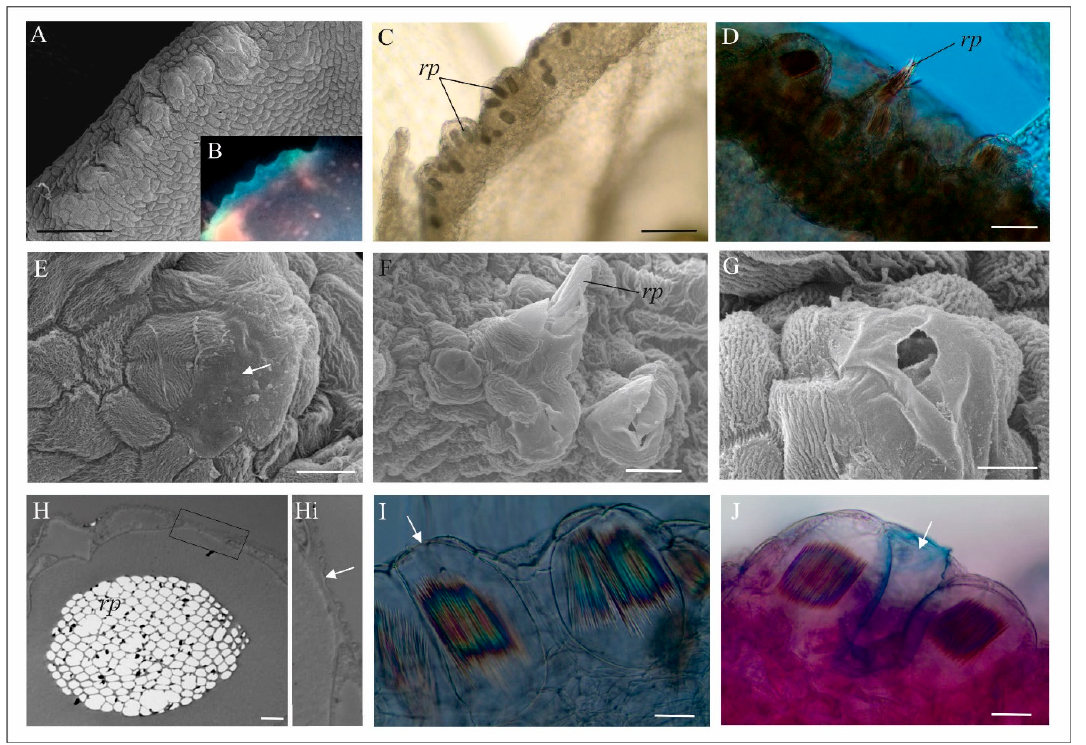
Figure 6. The cells with raphides in the M. monophyllos labellum . ( A ) The bulged structures on the labellum margin (SEM); ( B ) Luminescence of the labellum margin in the UV light (330–380 wavelengths) (LM); ( C ) idioblast with the raphides (fixed cells without staining) (LM); ( D ) raphides after ejection from the idioblasts (LM, DIC); ( E – G ) The bulged structures on the labellum margin-details (SEM); cells with striped cuticle and a single cells with smooth cuticle (arrow ) ; visible ejected raphides ( F ) and perforation ( G ) in the thin, smooth cuticle; ( H ) bundle of the raphides in the idioblast; ( Hi ) inset—fragment of the idioblast cell wall borders with the external environment (TEM); ( I , J ) Idioblasts with the raphides in the subepidermal cells; the fragment of the cell wall borders with the external environment (arrow); ( I ) and idioblast without raphides and with torn cell wall ( J ) (LM, DIC). Scale bars: 100, 100, 20, 20, 20, 20, 10, 20, 20 µm. e —epidermis, rp —raphides.